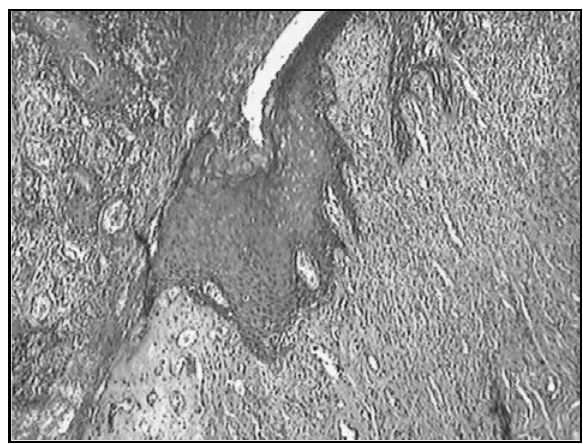
Figure 1 – Tongue invasive squamous cell carcinoma (hematoxylin-eosin,